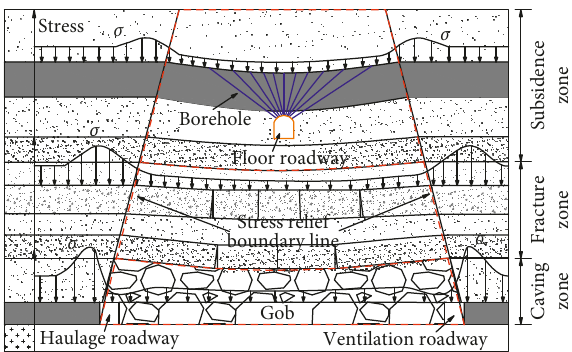
Figure 1: Gas extraction in the unloaded coal seam after protective layer